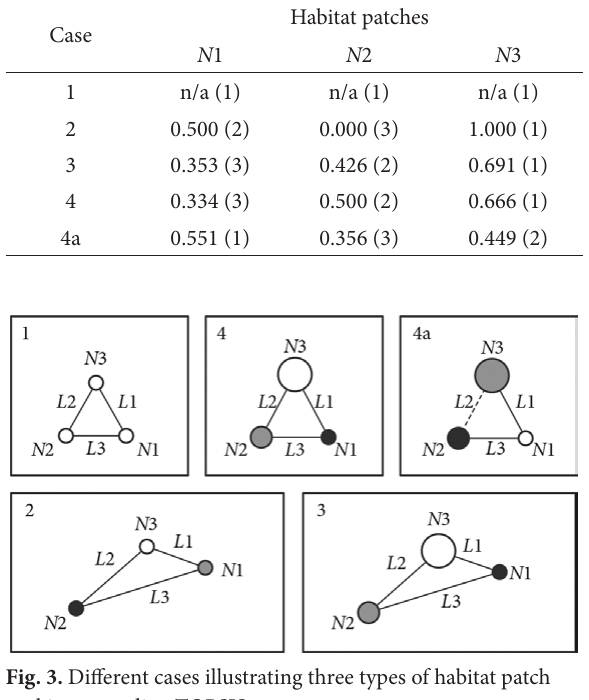
Table 4. Results of habitat patch ranking. TOPSIS (priority row within particular case) Case